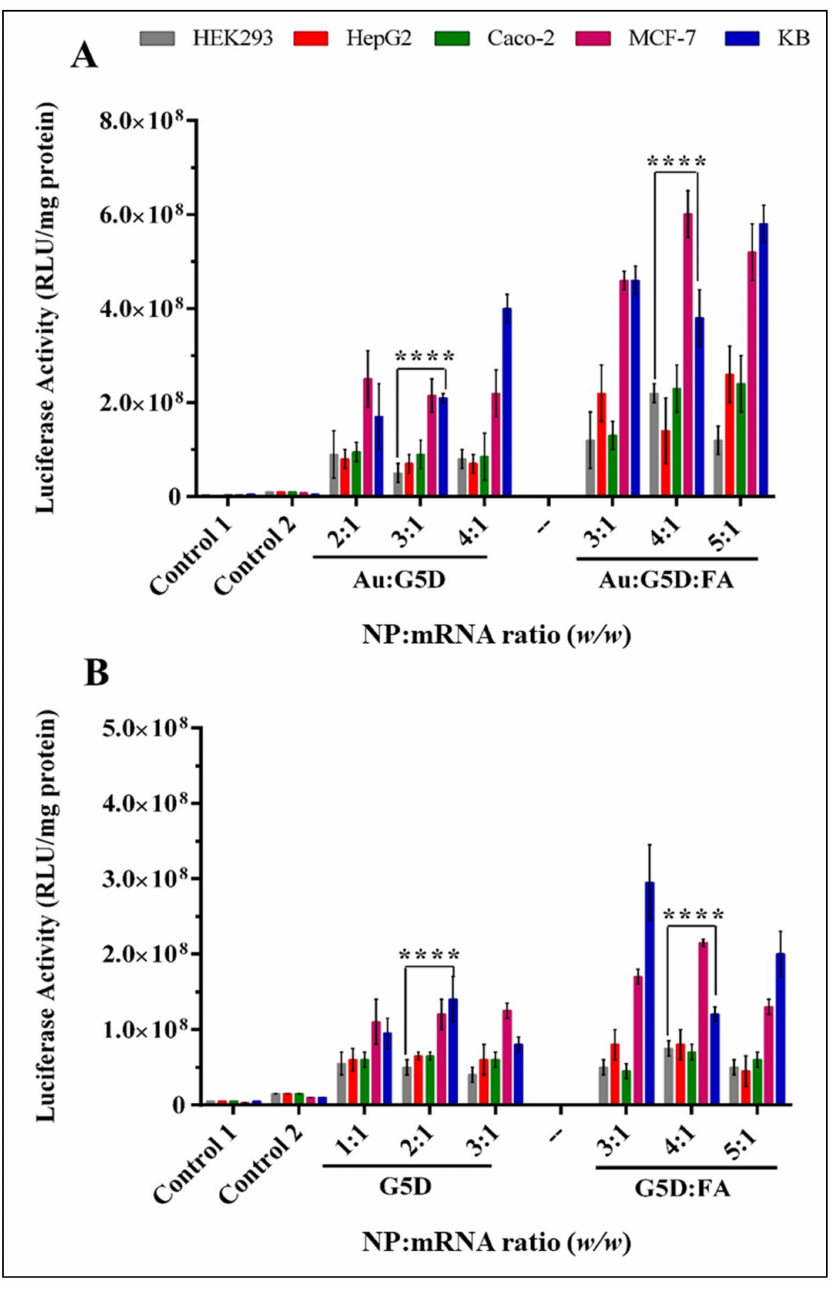
Figure 9. Transgene expression for ( A ) Au:G5D and Au:G5D:FA nanocomplexes, and ( B ) G5D and G5D:FA nanocomplexes in HEK293, HepG2, Caco-2, MCF-7, and KB cells. Nanocomplexes contained 0.05 µ g mRNA with varying amounts of nanoparticles to constitute the sub-optimum, optimum, and supra-optimum ( w / w ) ratios. Control 1 = untreated cells. Control 2 = cells treated with naked F Luc - mRNA. The transgene expression is reported as RLU/mg protein. Data are presented as means ± SD ( n = 3). **** p < 0.0001 for optimum